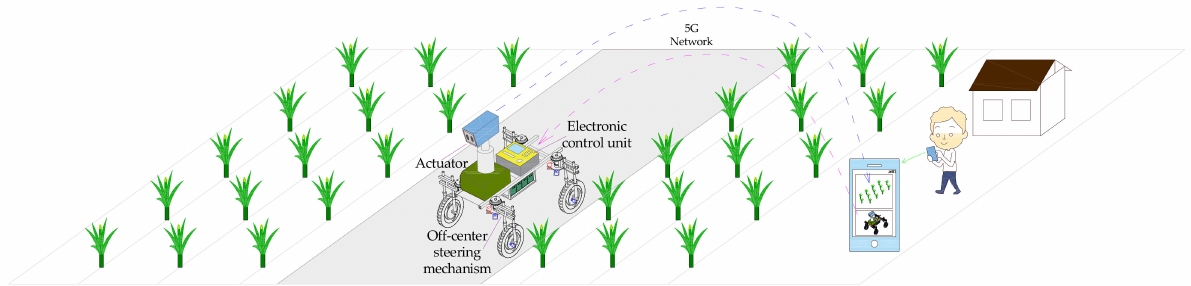
Figure 1. Working diagram of the wheeled-robot chassis.